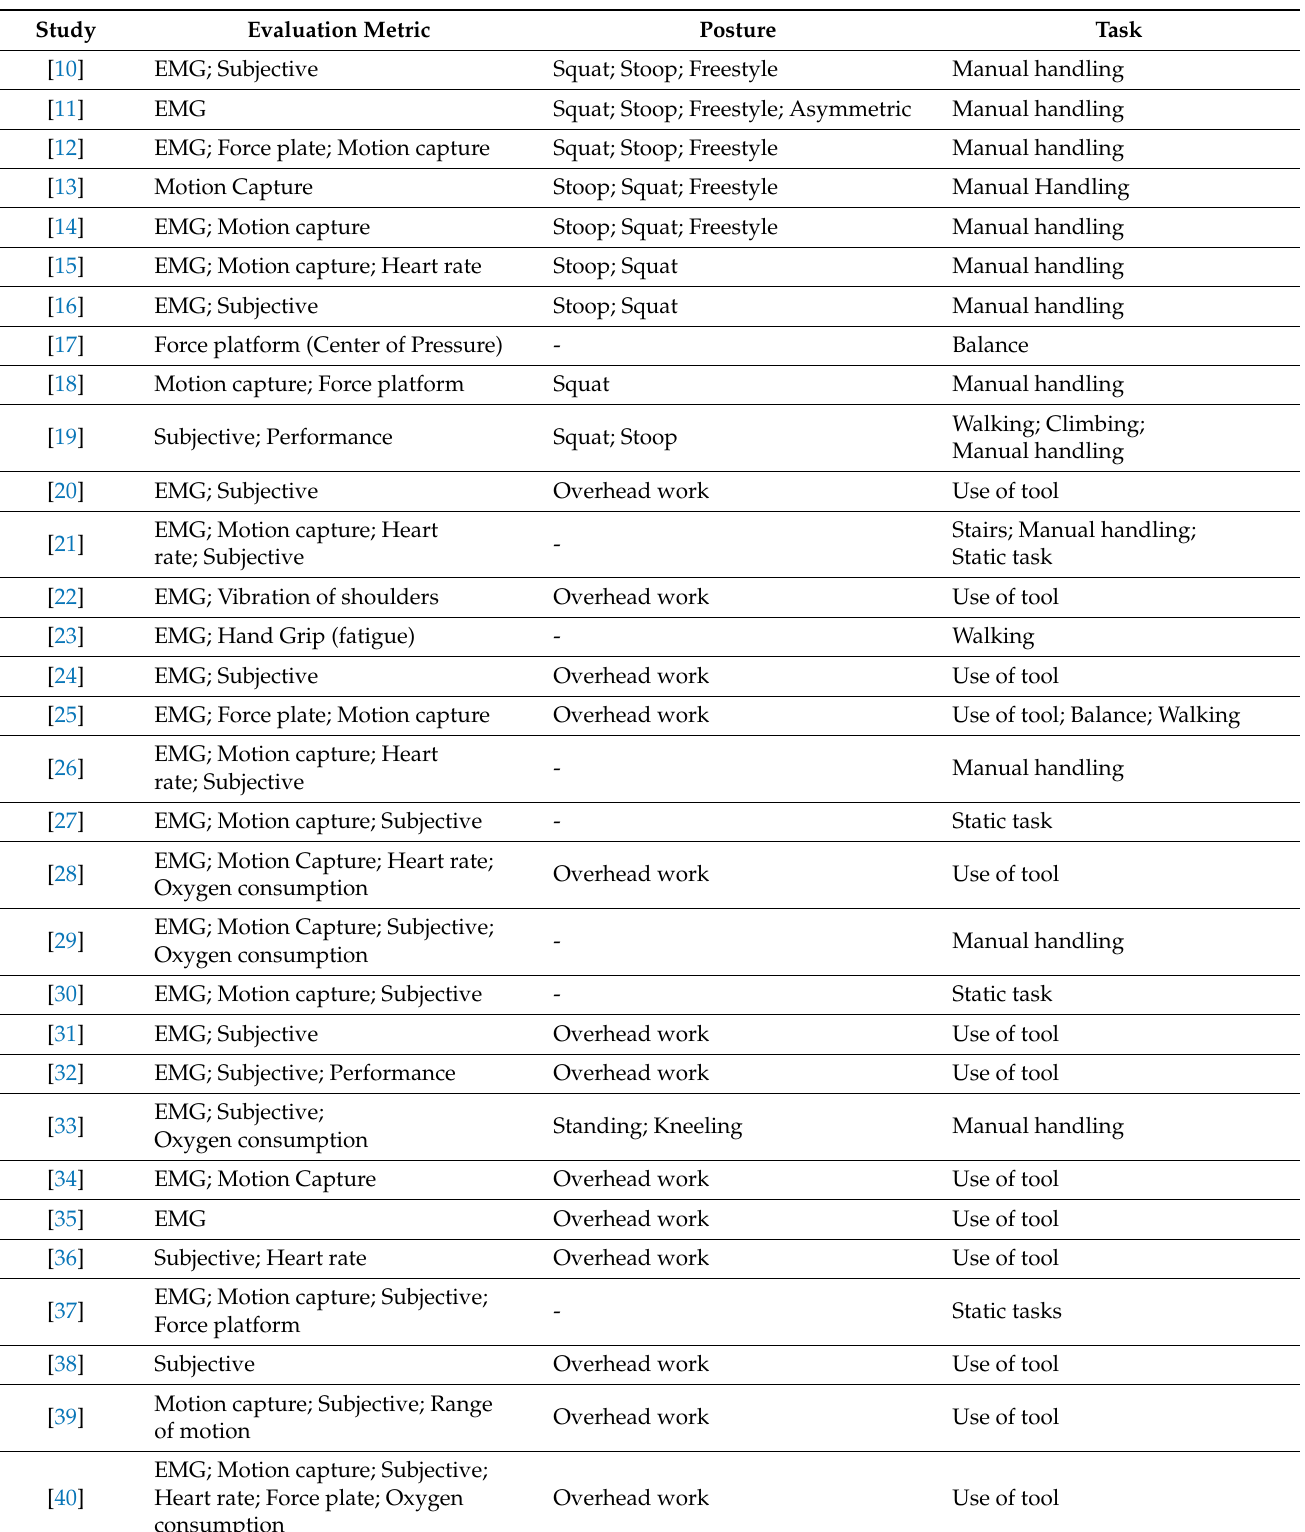
Table 6. Exoskeletons evaluated in the identified